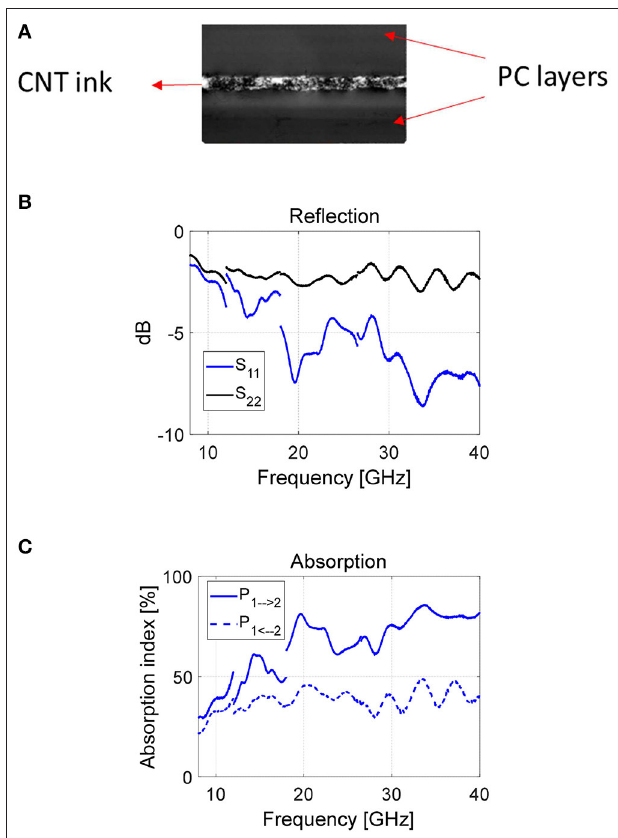
FIGURE 5 | TEM image of sandwich PC-CNT ink (A) , adapted from Danlée et al. (2014) measured reflection coefficient of a stack of sandwich PC-CNT ink layers having increasing concentration (B) corresponding absorption measurement (C)